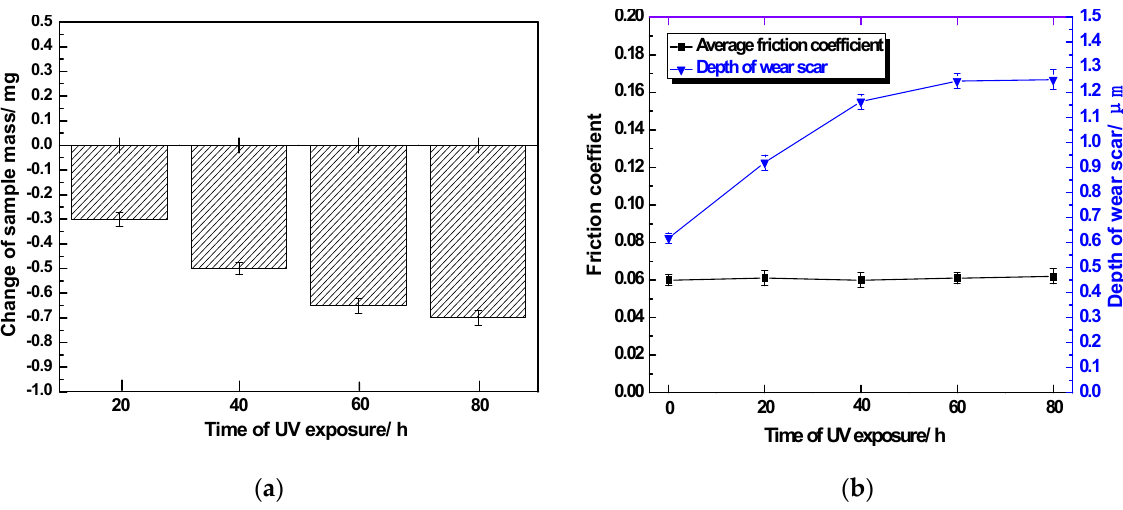
Figure 5. The mass and tribological properties of Mo/MoS 2 -Pb-PbS film after UV radiation for different time. ( a ) mass change; ( b ) average friction coefficient and variation of wear scar depth with radiation time.